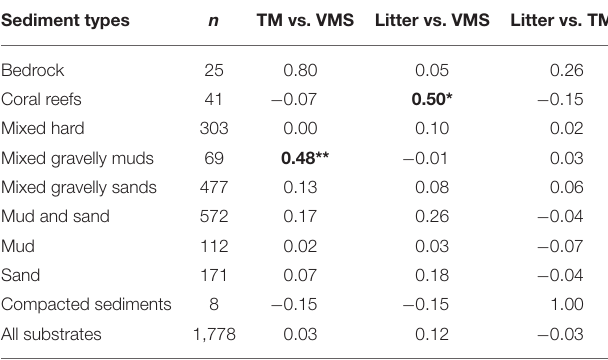
TABLE 2 | Number of locations with dominance of different sediment types ( n ), and correlation (Pearson product-moment correlation) values ( r ) between trawl marks (TM), density of vessel monitoring system records (VMS), and density (no of items per km 2 ) of observed litter for different